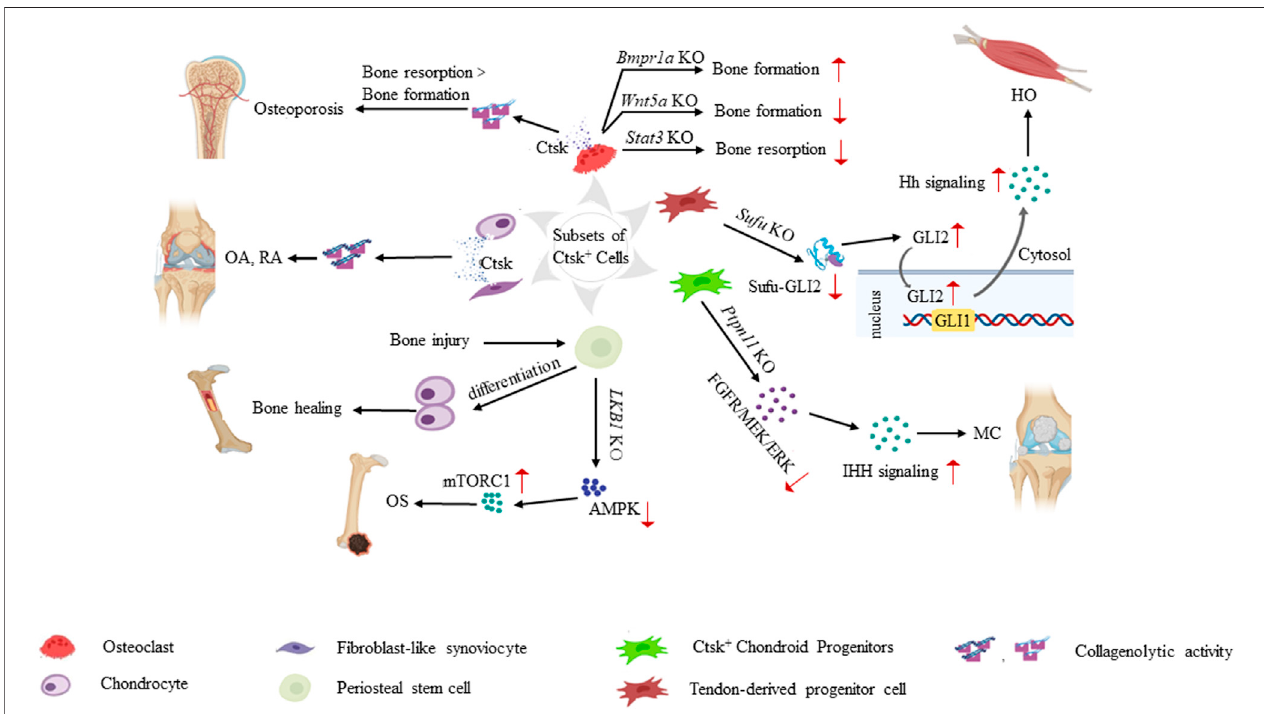
FIGURE2| RoleofCtsk + cellsinthepathogenesisofvariousskeletalsystemdiseases.Ctsk + cellshelpdeterminetheorigincellsofsomemusculoskeletalsystem- related diseases. Increased secretion of Ctsk from mature osteoclasts and chondrocytes leads to enhanced collagenolytic activity and subsequently contributes to osteoporosis,OA,andRA.Knockoutsofsomekeygenes,suchas Bmpr1a , Wnt5a ,and Stat3 inCtsk + osteoclastsbreakthebalanceofboneformationandresorption. In Ctsk + mesenchymal stem/progenitor cells, Ctsk serves as a genetic marker and helps us deeply understand the property and function of mesenchymal stem/ progenitor cells. PSCs play a signi fi cant role in intramembranous bone formation under physiological conditions. They differentiate into chondrocytes after bone injury, thereby participating in endochondral bone formation to promote bone healing. PSCs also serve as pathological precursors in osteogenic tumors through the LKB1/ AMPK/mTORC1 signaling pathways. Ptpn11 depletion in CCPs leads to MC via the ERK and Ihh signaling pathways. Ctsk + TDPCs with targeted Sufu deletion result in heterotopic HO via Hh pathway activation. Translocation of GLI2 from the cytoplasm to the nucleus transactivates the GLI1 promoter. Increased Gli1/Gli2 in Ctsk + TDPCs enhances the Hh signaling activity and promotes HO progression.